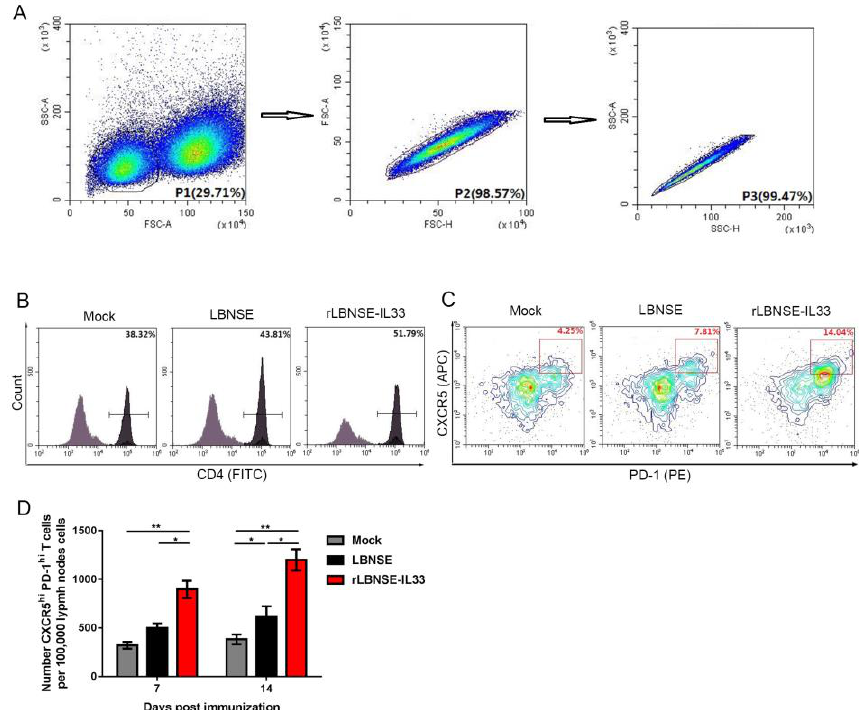
Figure 5. Overexpression of IL-33 by rRABV induced the generation of Tfh cells. Inguinal LNs from six-week-old BALB/c mice i.m. injected with LBNSE (10 6 FFU), rLBNSE-IL33 (10 6 FFU), or DMEM were collected and made into 10 5 single-cell suspensions at 7 and 14 dpi, and then the suspensions were stained with antibodies for flow cytometry analysis: ( A ) target Cells were visualized with dot plots to show their forward-scatter (FSC) and side-scatter (SSC) signals respectively representing size and granularity of the cells; ( B , C ) gating strategies and contour plots respectively representing the CD4 + T cells in lymphocytes ( B ) and Tfh cells in CD4 + T cells ( C ); ( D ) total number of Tfh cells per 10 5 draining LN cells at 7 and 14 dpi. The standard error (SE, n = 3) was illustrated by error bars, and the data were analyzed by unpaired two-tailed t -test. Significant differences between groups were indicated at the levels: *, p < 0.05 and **, p <